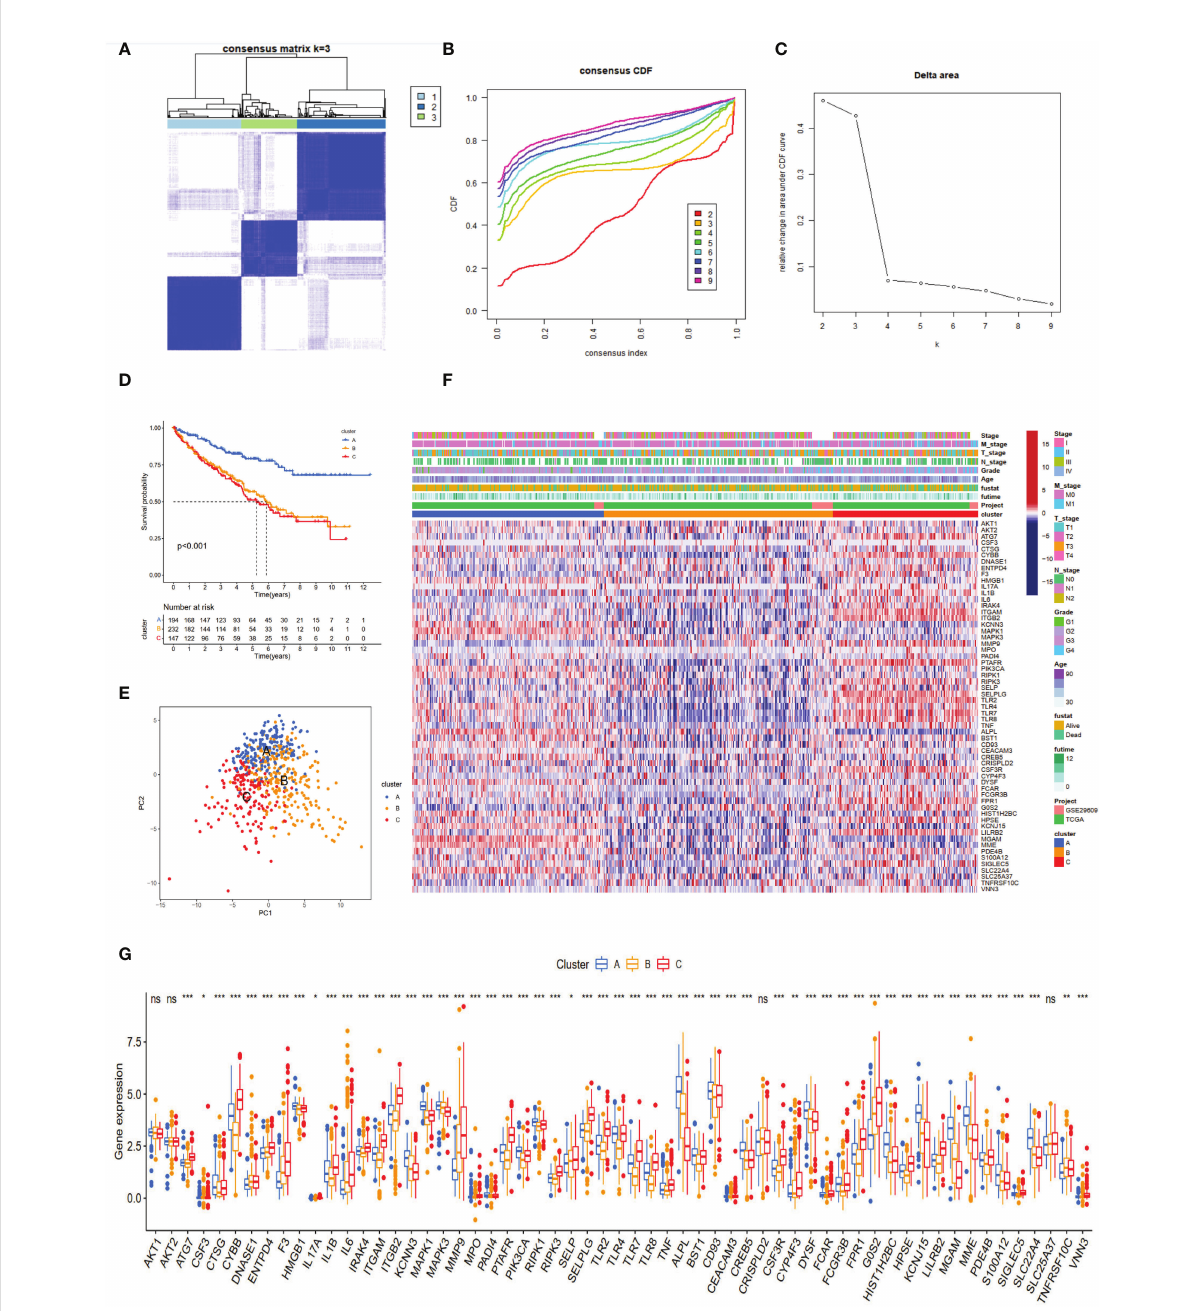
FIGURE 2 NET subtypes and clinicopathological features of three clusters. (A) Consensus matrix of ccRCC samples ’ co-occurrence proportion for k = 3. (B, C) Consensus clustering CDF for k from 2 to 9. (D) The Kaplan – Meier plot showed the overall survival differences among the three subtypes in the ccRCC cohorts. (E) Principal component analysis of ccRCC samples grouped by clusters. (F) Heatmap showing the association of subtypes with clinical characteristics and expression of neutrophil extracellular trap-associated genes. (G) The boxplot of neutrophil extracellular trap-associated genes among different clusters. ns, no signi fi cance. *p < 0.05, **p < 0.01, ***p <